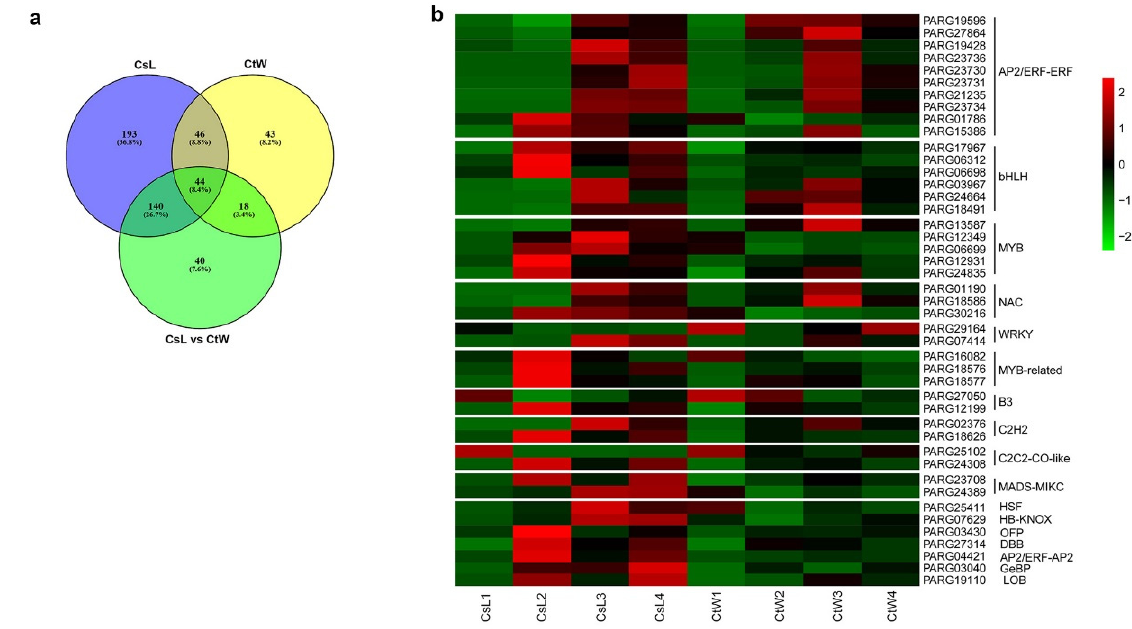
Figure 2. Analysis of differently expressed transcription factors (TFs) under freezing treatment. ( a ) Venn diagram showing the shared and specific number (and ratio) of differently expressed TFs identified in CtW, CsL, and CtW vs. CsL. ( b ) Heatmap of overlapping TFs between CtW, CsL, and CtW vs. CsL. Each column represents the gene expression at different temperatures (20 °C, − 2 °C, − 3 °C, and − 4 °C) in CtW and CsL.